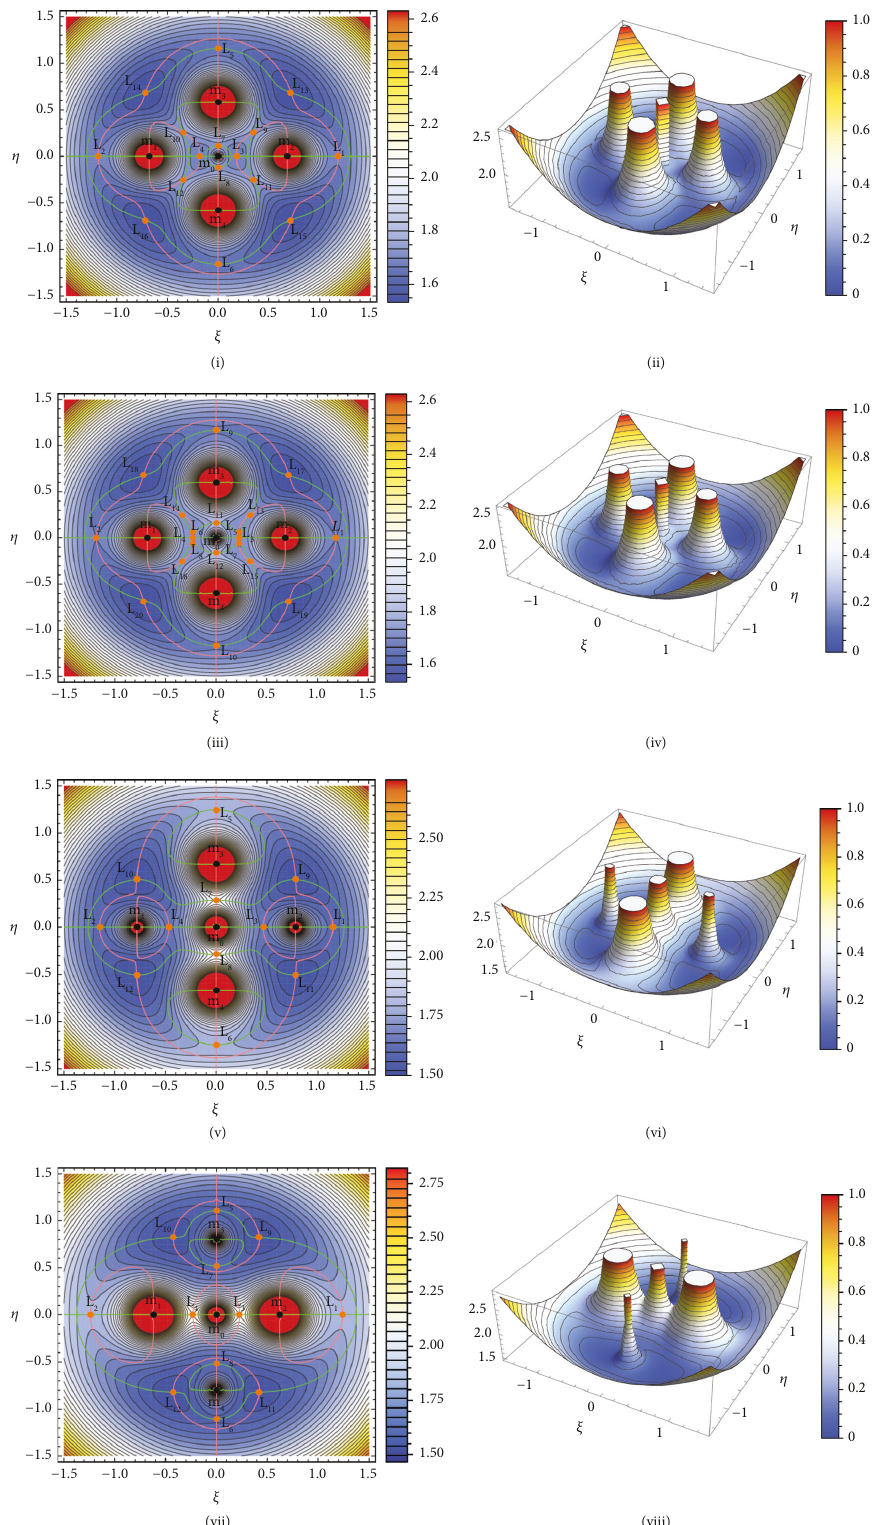
Figure 6: Left: zero velocity curves and contour plots with Lagrange points for different values of a and b in 2D, Right: corresponding effective potential for different values of a and b , a � 0 . 68 and b � 0 . 58: for (i) and (ii), a � 0 . 68 and b � 0 . 60: for (iii) and (iv), a � 0 . 78 and b � 0 . 67: for (v) and (vi), a � 0 . 62 and b � 0 . 80: for (vii) and